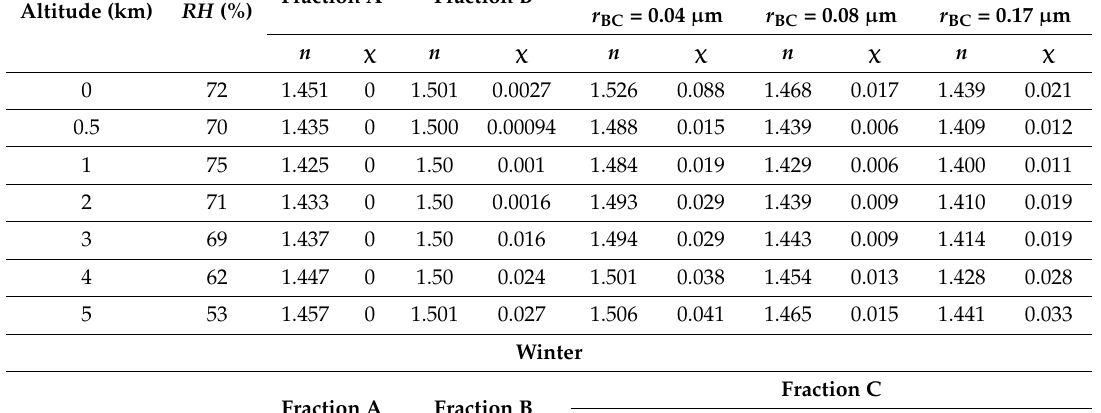
Table 2. Relative humidity and refractive indices of fraction at different altitudes in winter and summer.